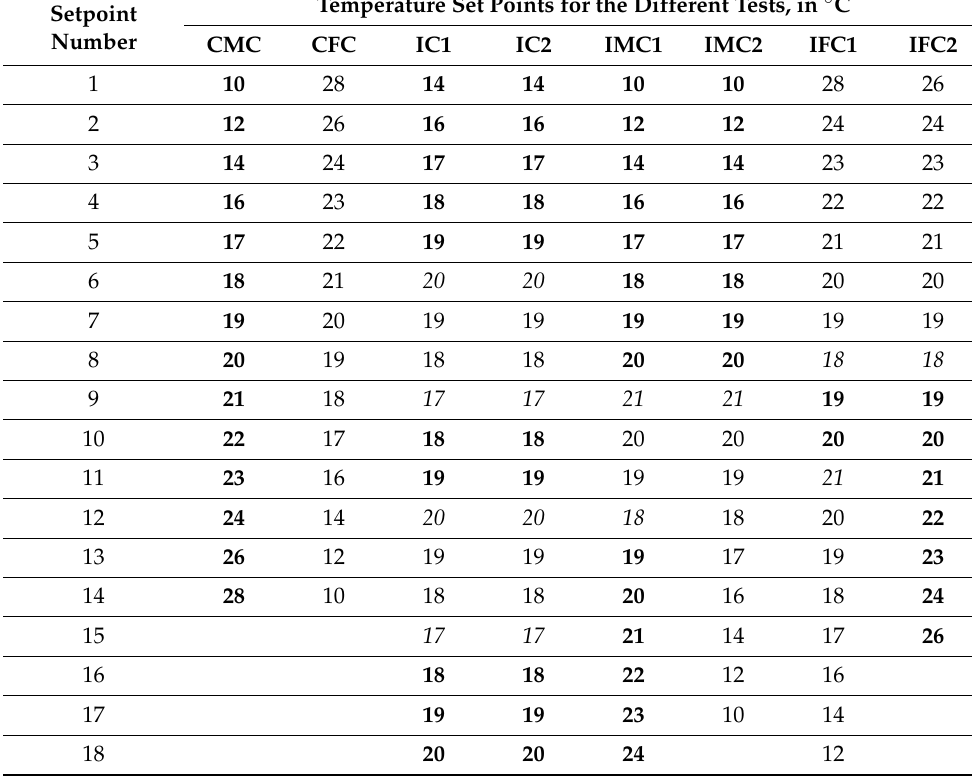
Table 1. Temperature setpoints for different test cycles.